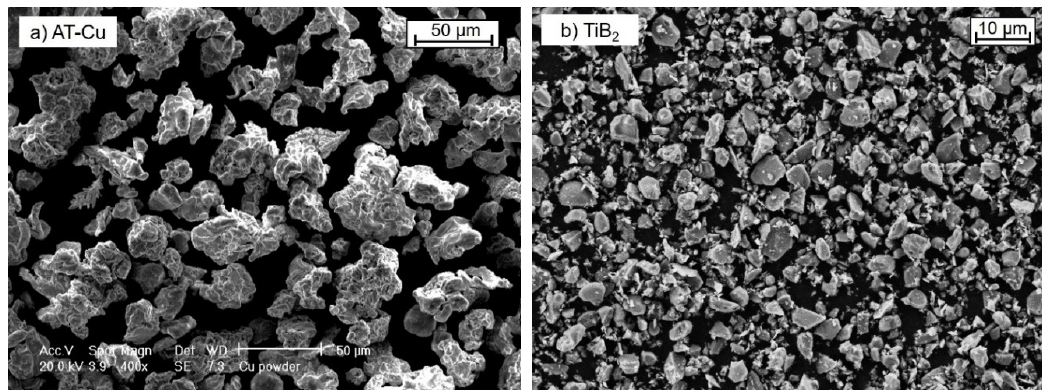
Figure 1. SEM micrographs of ( a ) water atomized Cu powder (AT-Cu) and ( b ) blend of TiB 2 . Table 1. Nominal composition of the AT-Cu and TiB 2 powders (weight %).